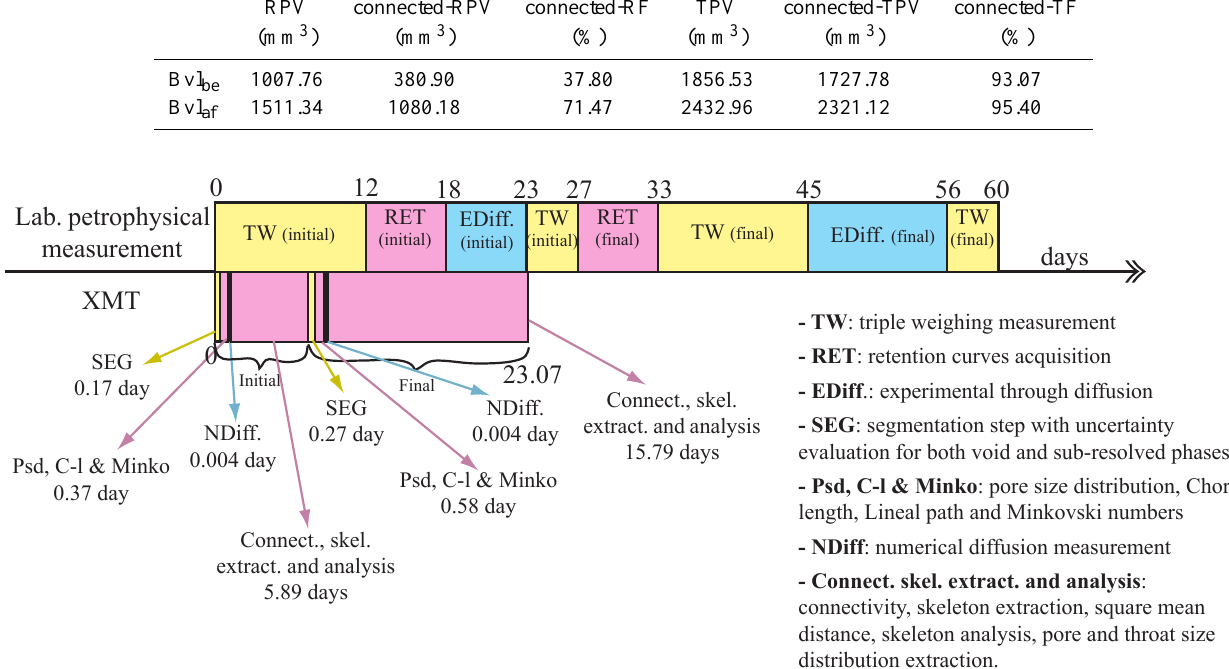
Figure 11. Time scale of the different methods used in this study for both laboratory and XMT images